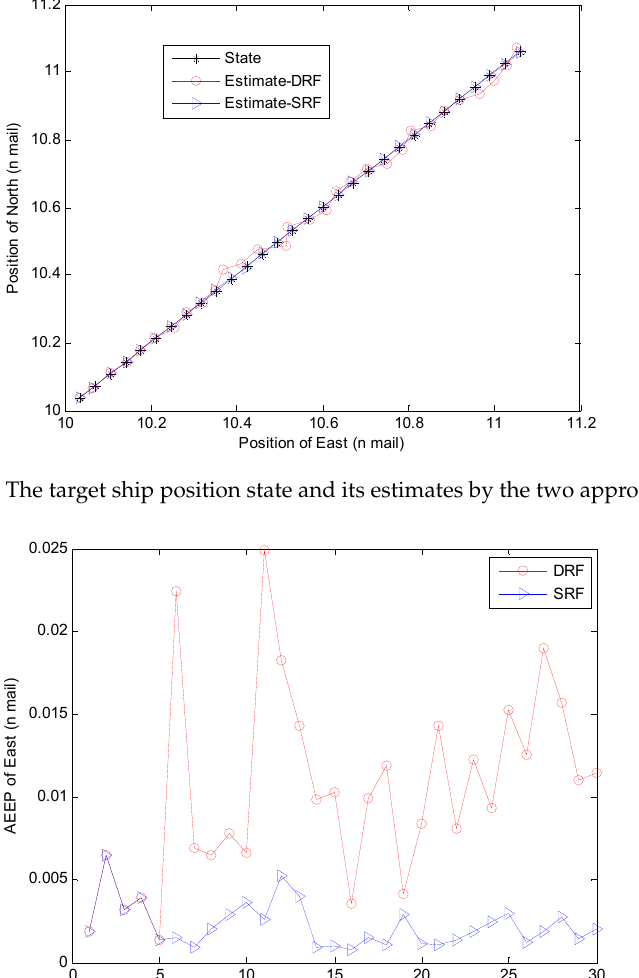
Figure 5. The absolute estimation error of north position.